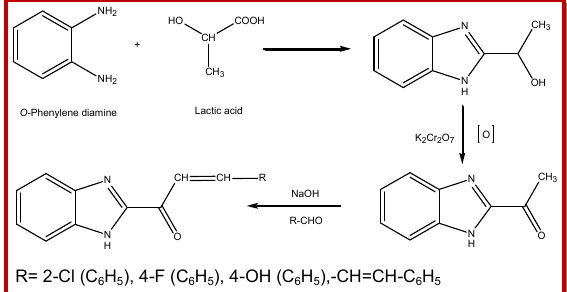
Scheme 1: Synthesis of benzimidazole